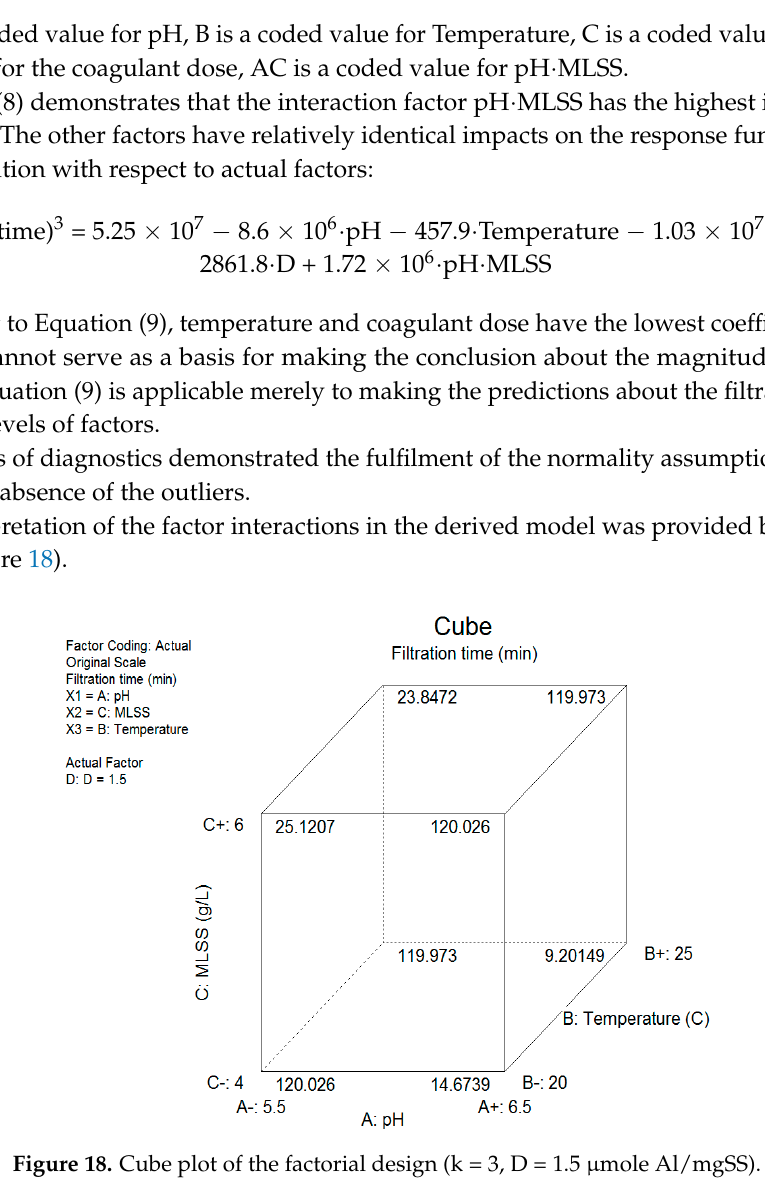
Figure 18. Cube plot of the factorial design (k = 3, D = 1.5 μ mole